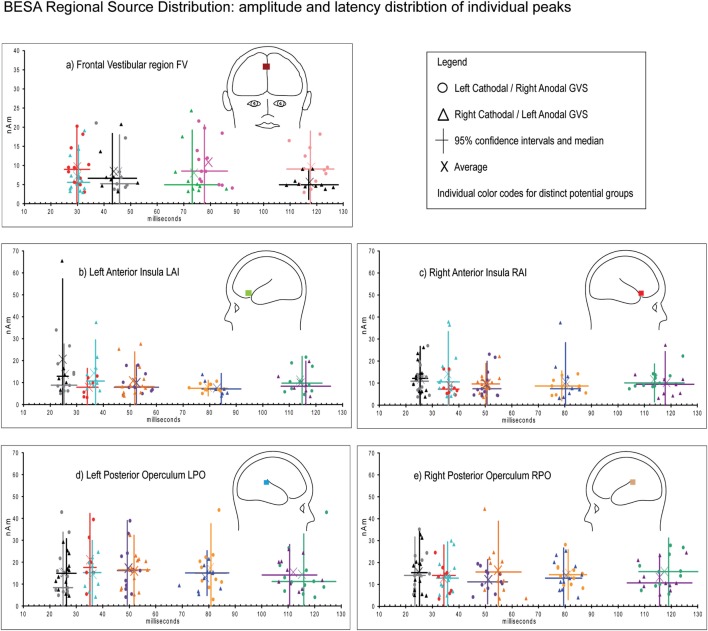
Galvanic vestibular-evoked potentials in the five investigated cortical regions FV (A), right anterior insula (RAI) (B), left anterior insula (LAI) (C), right posterior operculum (RPO) (D), and left posterior operculum (LPO) (E) with the individual subjects’ potential latencies and amplitudes for left cathodal stimulation (circles) and right stimulation (triangles) with individual colors to distinguish potential clusters at 25, 35, 50, 80, and 110 ms in RAI, LAI, RPO, and LPO and 30, 45, 70, and 110 ms in frontal regions FV. The potential latencies were significantly different from one another within one region (Table 2), whereas no explicit effects were found for side of stimulation on either amplitude or latency or between cortical regions of interest.